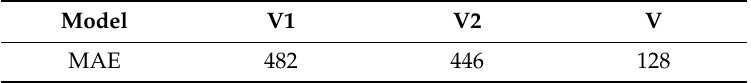
Table 5. Average absolute error of di ff erent visibility estimation methods